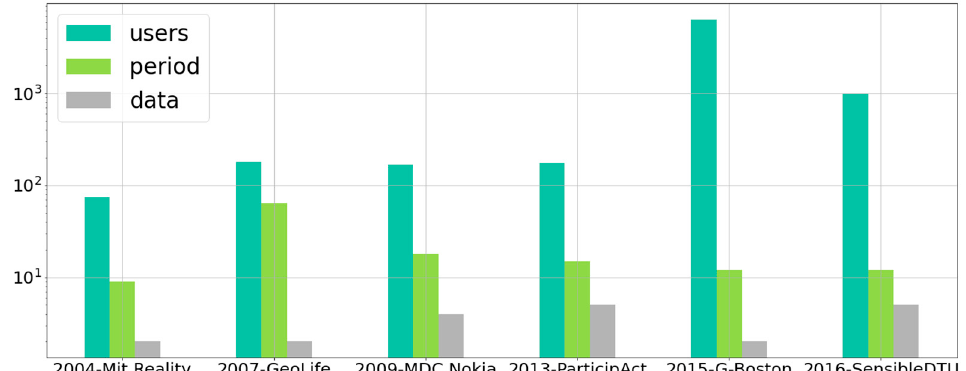
Figure 1. Evolution of the mobility data sets in terms of: number of users, time duration and heterogeneity of collected